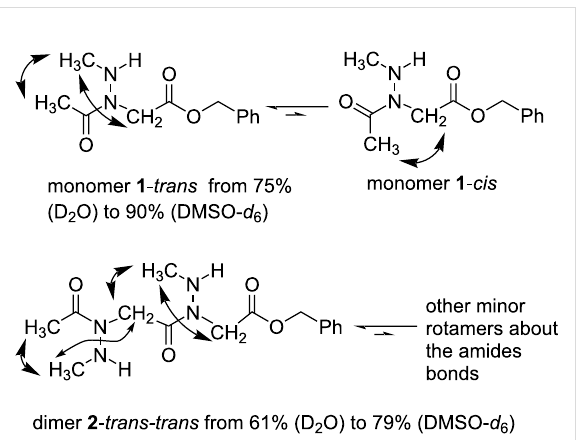
Figure 4: NOE effect interaction observed in the 2D-NOESY spectra of monomer 1 and dimer 2 in DMSO- d 6